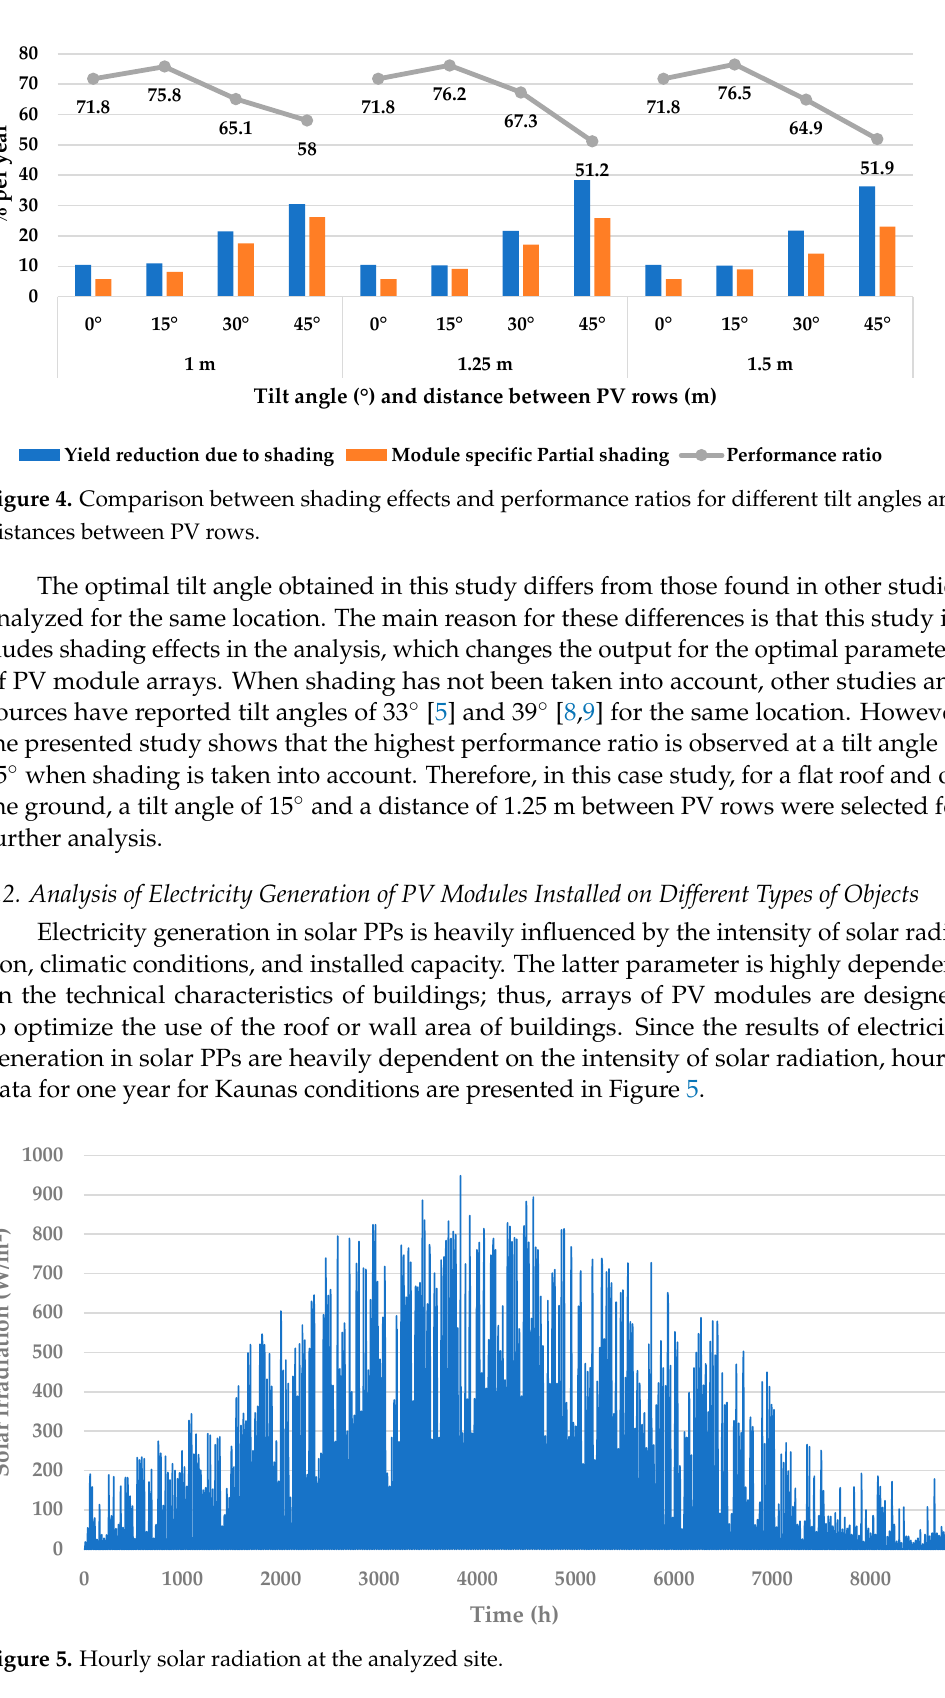
10 of 20 Figure 3. Shading durations at different tilt angles: ( a ) 0°, ( b ) 15°, ( c ) 30°, and ( d ) 45°. It was also observed that the main factor behind these results was the shadow that